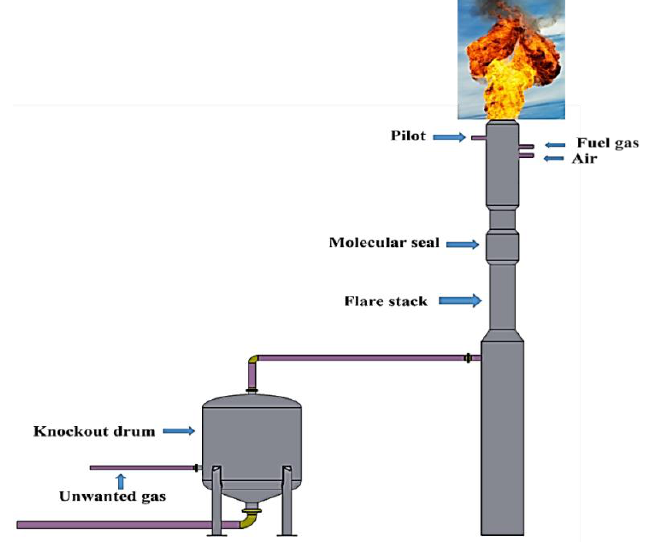
Figure 1. Flaring system component.